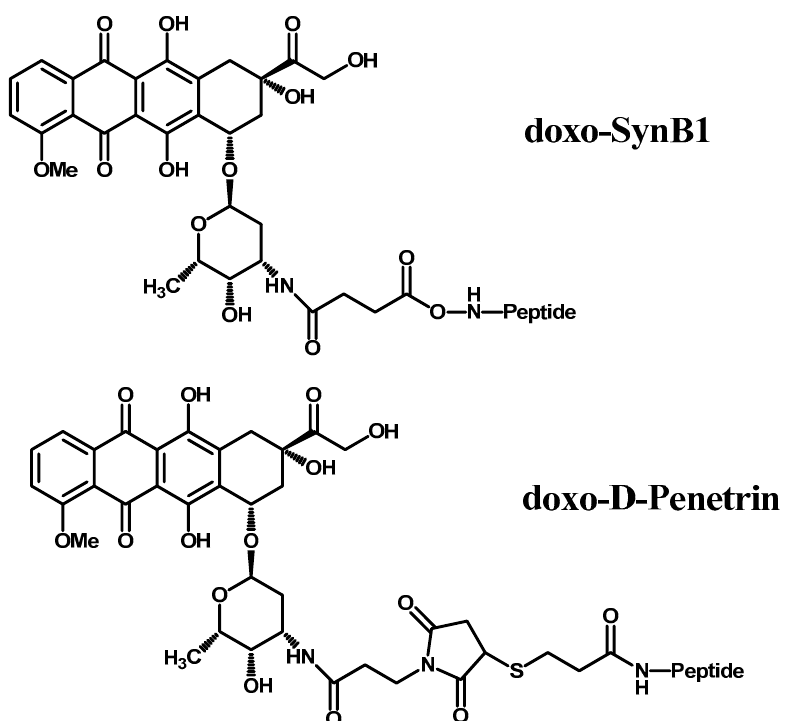
Figure 4. Chemical structures of doxo-SynB1 and doxo- D -Penetrin.